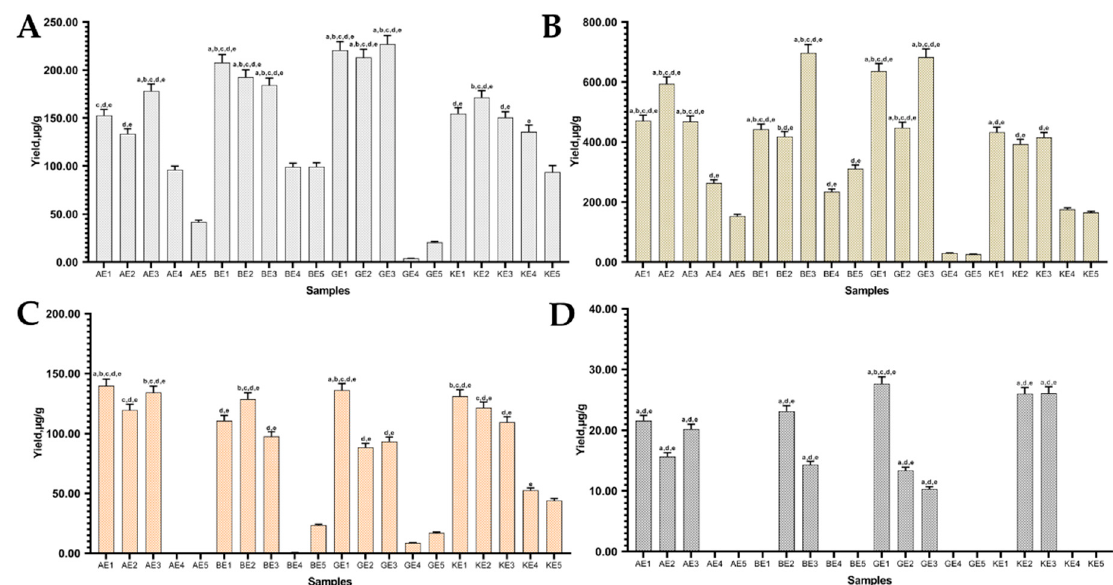
Figure 6. Quantitative yield of isoflavone aglycones (( A ) genistein and ( B ) daidzein) and glycosides (( C ) genistin and ( D ) daidzin) using excipients (1%) and 50% ethanol as a solvent. Control samples without excipients (KE1-5), samples with α -CD (AE1-5), β -CD (BE1-5), γ -CD (GE1-5). a p < 0.05 vs. KE1, b p < 0.05 vs. KE2, c p < 0.05 vs. KE3, d p < 0.05 vs. KE4, e p < 0.05 vs. KE5. Sample codes are provided in Table 1.